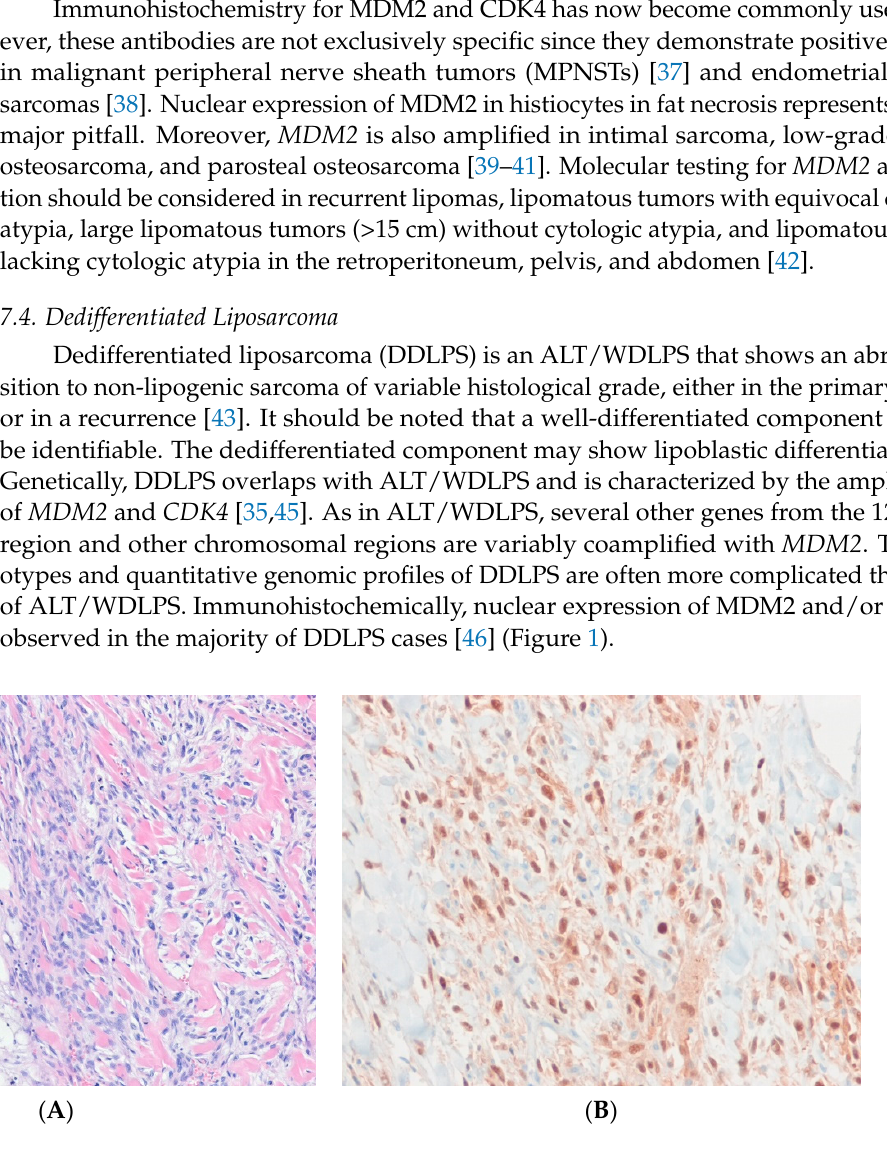
Figure 1. Dedifferentiated liposarcoma. ( A ) The tumor shows an abrupt transition from a well- differentiated liposarcoma component (left) to a non-lipogenic sarcoma component (right), MDM2 (H&E stain, × 100). ( B ) The dedifferentiated part shows nuclear positivity for MDM2, indicating the presence of underlying MDM2 amplification (immunohistochemical stain for MDM2, × 200). MDM2 immunohistochemistry and MDM2 amplification can help confirm a diagnosis of DDLPS and distinguish DDLPS from other undifferentiated sarcomas in the relevant clinical context [47]. It has been reported that undifferentiated pleomorphic sarcomas with MDM2 amplification are in fact DDLPS even in the absence of a well-differentiated LPS component